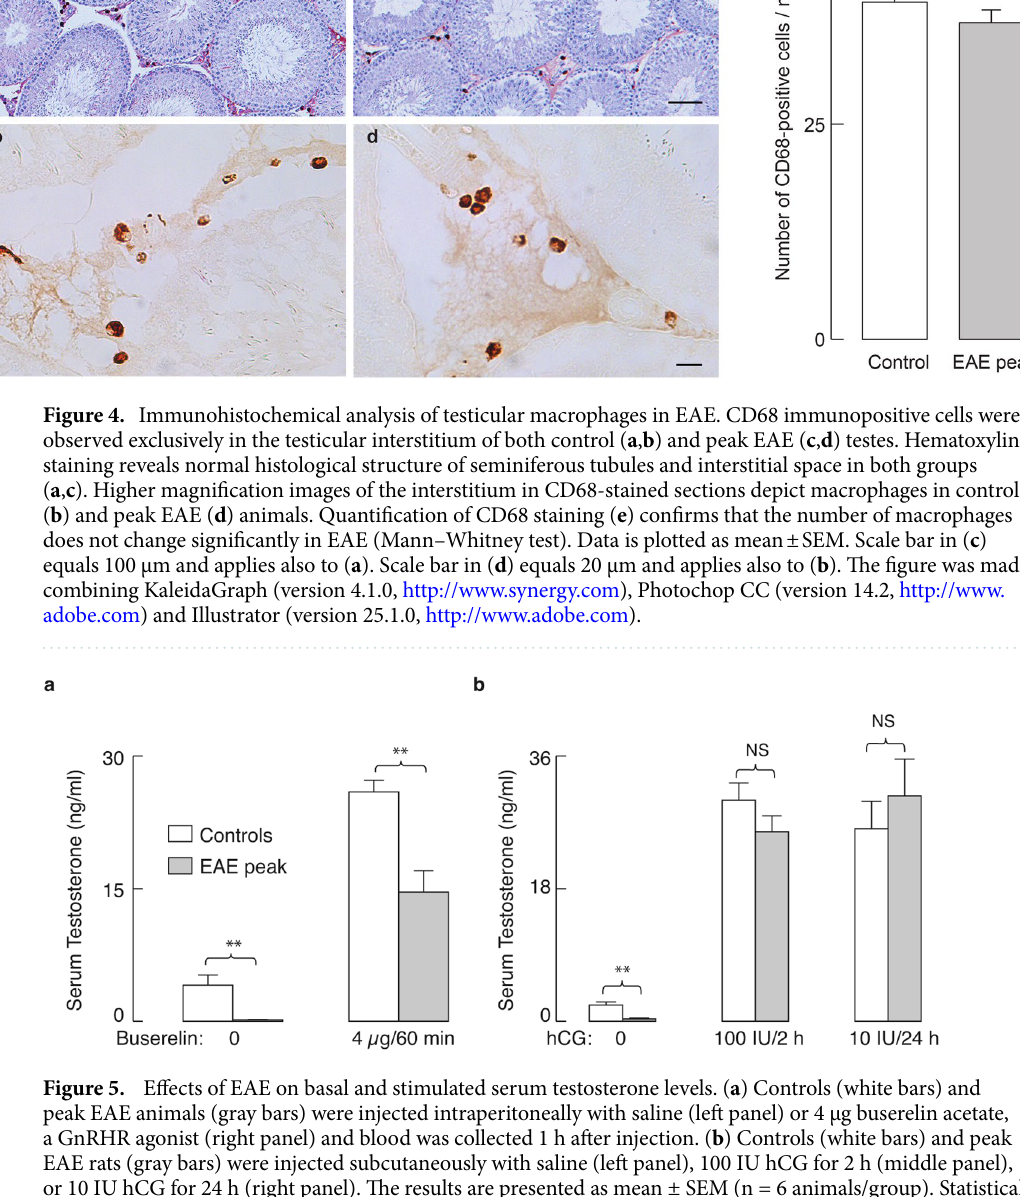
amplitude between those two groups was observed ( P < 0.01). The poorer response of diseased animals to buser- elin acetate is in line with our recent findings that 1 h after this treatment, LH recovers in male rats at the peak of EAE, but does not reach the response amplitude of control animals 9 .